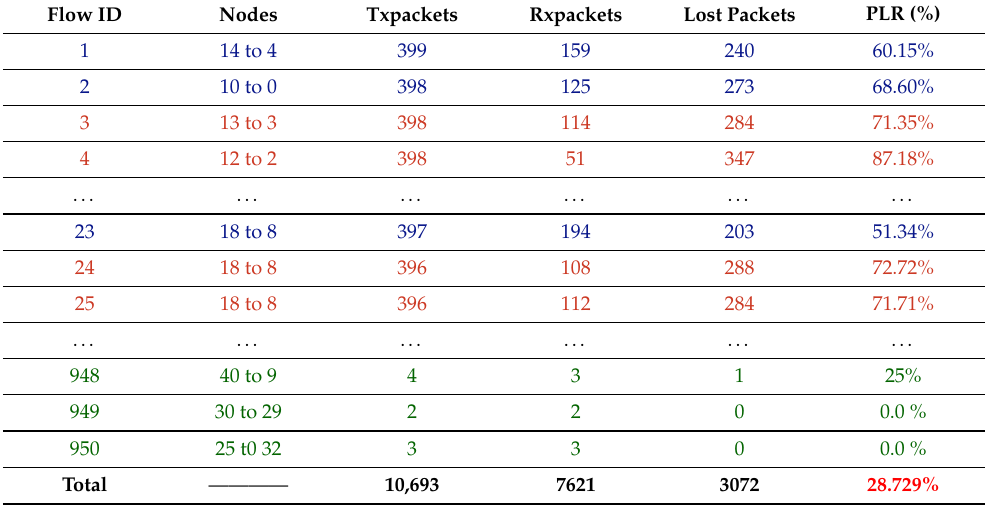
Table 3. Table of Flow IDs